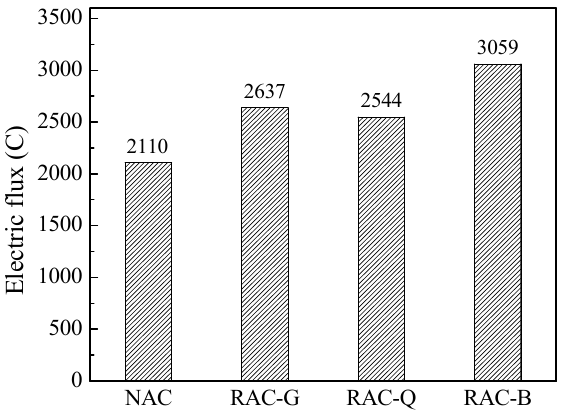
Figure 8. Electric flux of concrete.